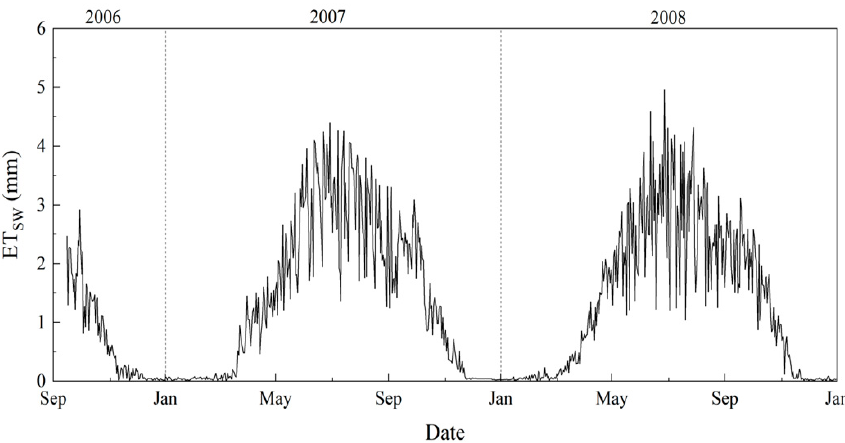
Figure 3. Annual variation of evapotranspiration estimated by the S–W model ( ET SW ) in the degraded meadow for 2006–2008. Table 2. Evapotranspiration partitioning during the study period.